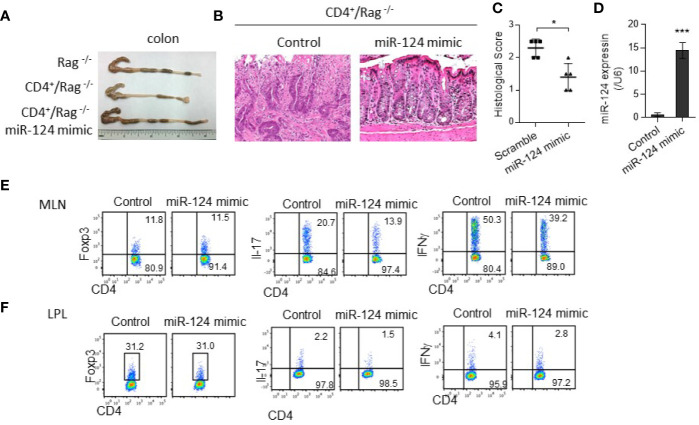
MiR-124 weakened the colitis in CD4 positive cell transfer model in vivo. CD4+CD45Rbhi T cells were purified from C57BL/6mice and 5 × 105cells were injected (i.p.) into recipient Rag1−/−mice. Mice were treated with control or miR-124 mimic (at 10 nm/mouse) every three days. (A) Morphology of intestines; (B) disease scores, *p < 0.05 versus recipients of control group (n = 5–6 mice per group); (C) sections of colons with colitis from Rag1−/− mice (n = 5–6 mice in each group) 8 weeks after naïve T cell transfer as described above. Scale bar, 100 μM. (D, E, F) The percentage of IL-17 -producing cells from mesenteric lymph nodes and LPL of Rag1−/− mice in control and miR-124 mimic treated group. ***p < 0.001 versus recipients of control treated group.